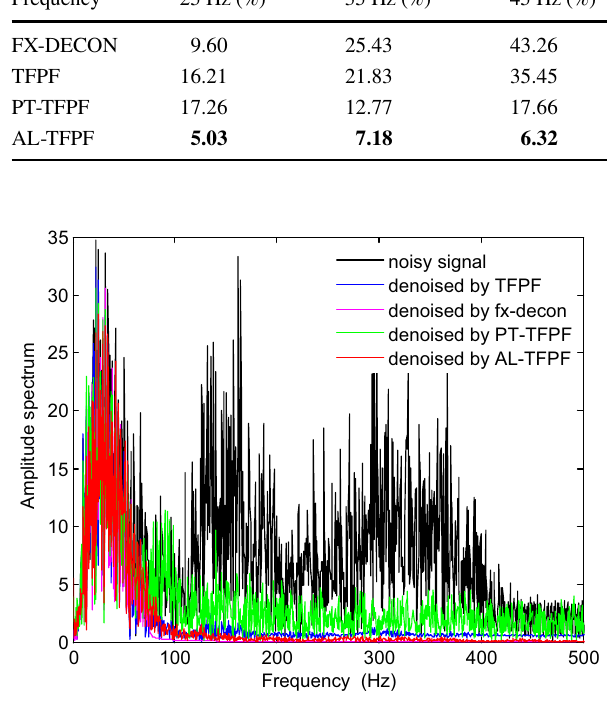
Fig. 13 Amplitude spectrums of single trace with different methods